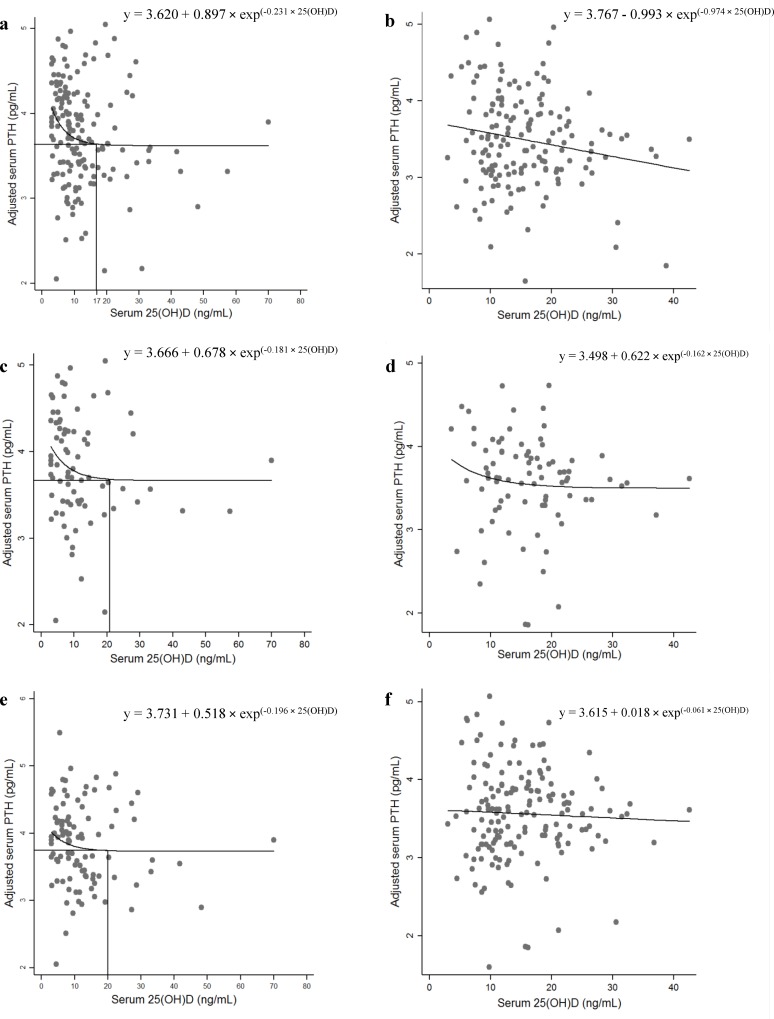
Sensitivity analysis: to assess the association of serum 25(OH)D and adjusted log-transformed iPTH concentrations using nonlinear regression analysis.(a) females with calcium intakes below EAR; (b) males with calcium intakes below EAR; (c) females with magnesium intakes below EAR; (d) males with magnesium intakes below EAR; (e) females with obesity; (f) males with obesity.